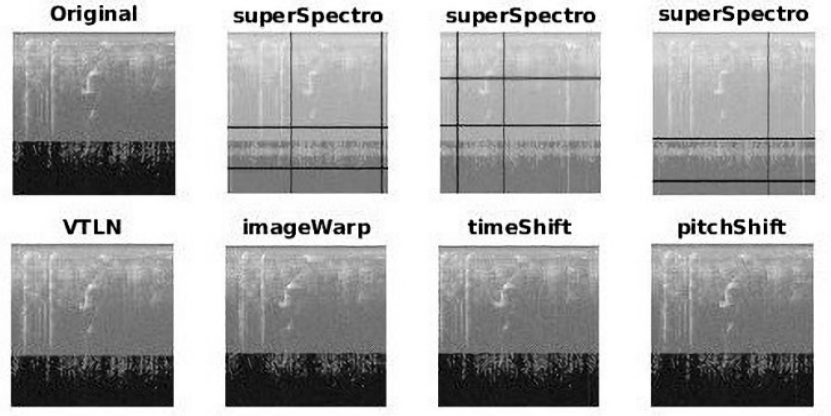
Figure 3. Spectrogram augmented samples (SSpa and SuSA). The horizontal axis in each image represents time, and the vertical axis represents frequency.